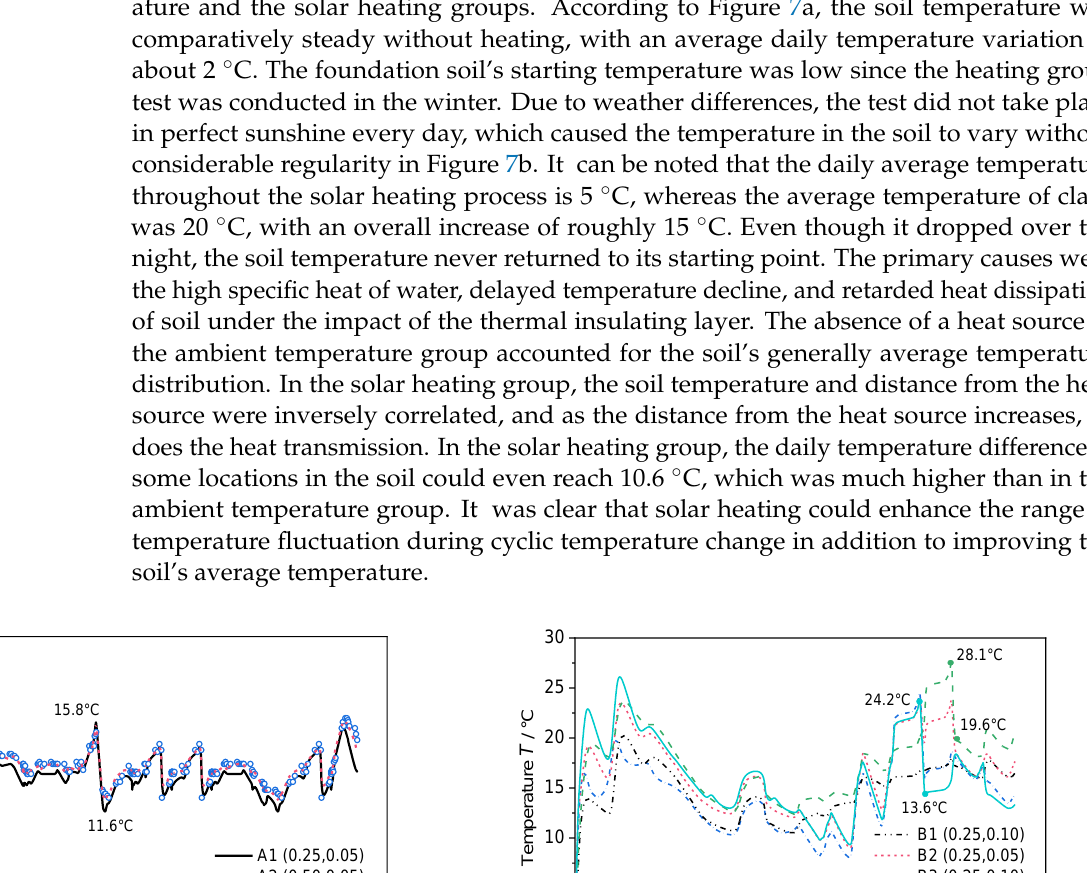
Figure 6. Location of pore water pressure gauge. ( a ) Ambient temperature group; ( b ) solar heating group.